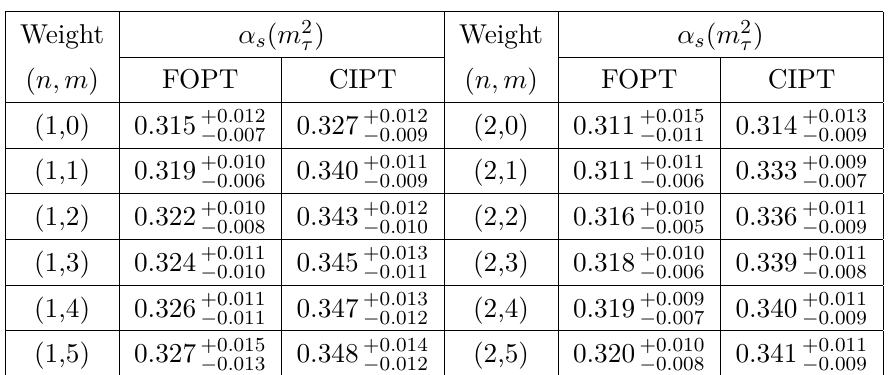
( s ) moment with weights 0 V + A